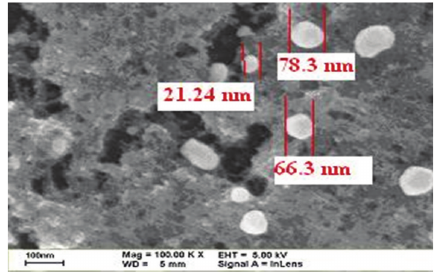
Figure 4: FE-SEM image showing the almost spherical Ag ap- proach.